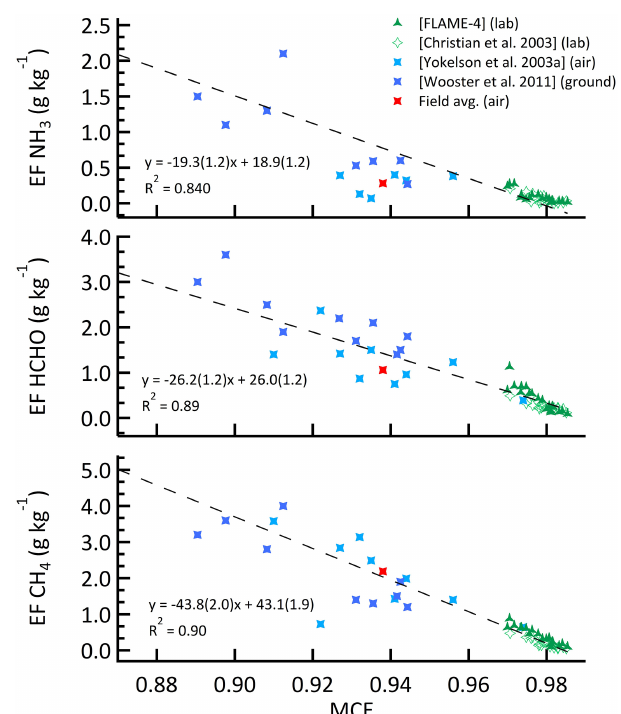
Figure 4. Emission factors (gkg − 1 ) of select smoldering species as a function of MCE for FLAME-4 burns of African savanna fuels. Also shown are laboratory data of Christian et al. (2003), ground- based data of Wooster et al. (2011), and airborne data of Yokelson et al. (2003a). The linear fit based on all data is